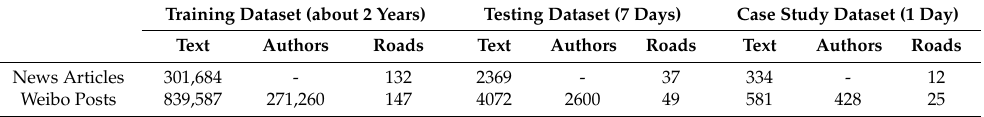
Table 2. The Dataset of cross-platform transportation in